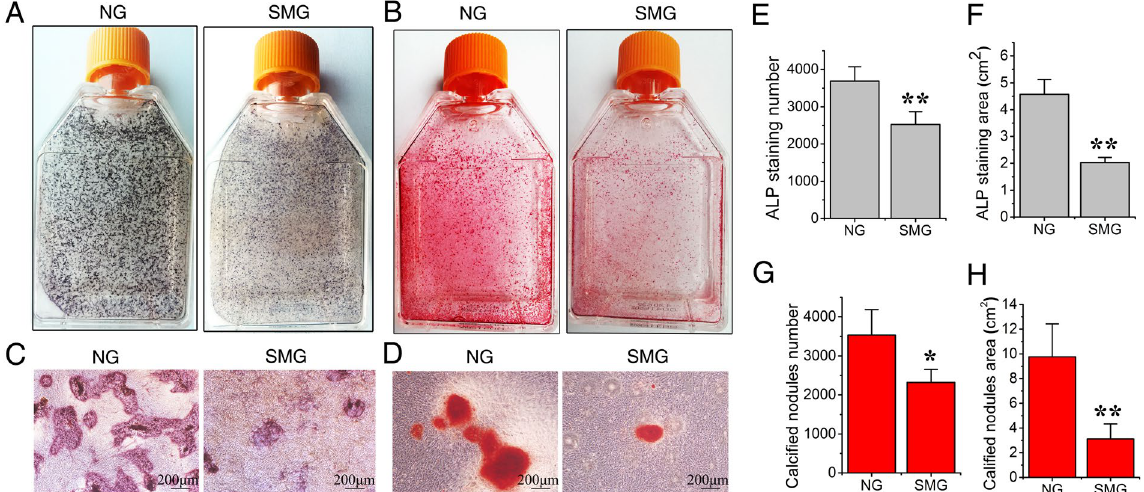
Figure 4. Simulated microgravity reduces the maturation and mineralization of rat calvarial osteoblasts (ROBs). ( A ) Representative image of the alkaline phosphatase (ALP) stained CFU-F ALP colonies after 8 days of random positioning machine (RPM) microgravity treatment. ( B ) Representative image of the stained mineralized nodules after 12 days of RPM treatment. ( C ) Enlarged image of the CFU-F ALP colonies under a phase contrast microscope. ( D ) Enlarged image of the mineralized nodules under a phase contrast microscope. ( E and F ) The numbers and areas of the CFU-F ALP . ( G and H ) The numbers and areas of the mineralized nodules. NG: normal ground, SMG: simulated microgravity. Each experiment was conducted at least three times independently. * P < 0.05 or ** P < 0.01 vs NG